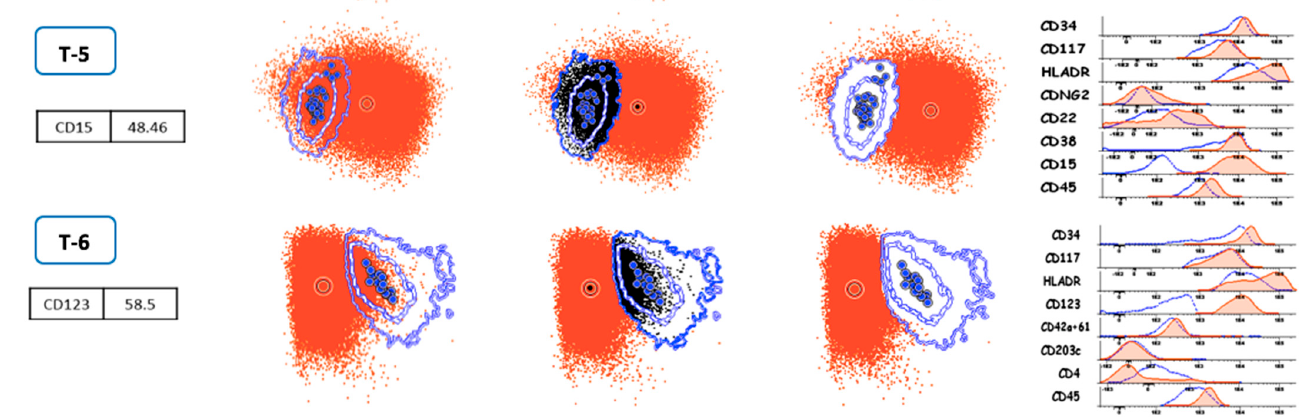
Figure 3. Phases of the analytical process at AML diagnosis. ( A ) Identification and selection of the leukemic population attending to the backbone markers by using an APS graph. ( B ) The compass tool included in the normality databases automatically classifies the population; the orange arrow points to the assigned compartment. ( C ) Comparison of the leukemic cluster with the assigned normal compartment. The overlapping events, indistinguishable from the normal phenotype, are excluded from the analysis. The description of the LAIPs is based on the main differences with respect to the indicated compartment (as shown in the histograms).